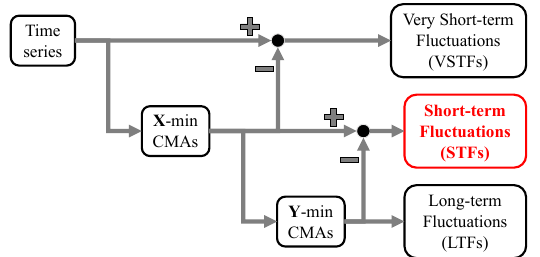
Figure 3. Procedure for separating very short-, short-, and long-term fluctuations from a time series using centered moving averages (CMAs). X and Y are